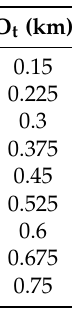
Figure 5. Relay node selection using N j calculation. Table 2. Optimal threshold against network